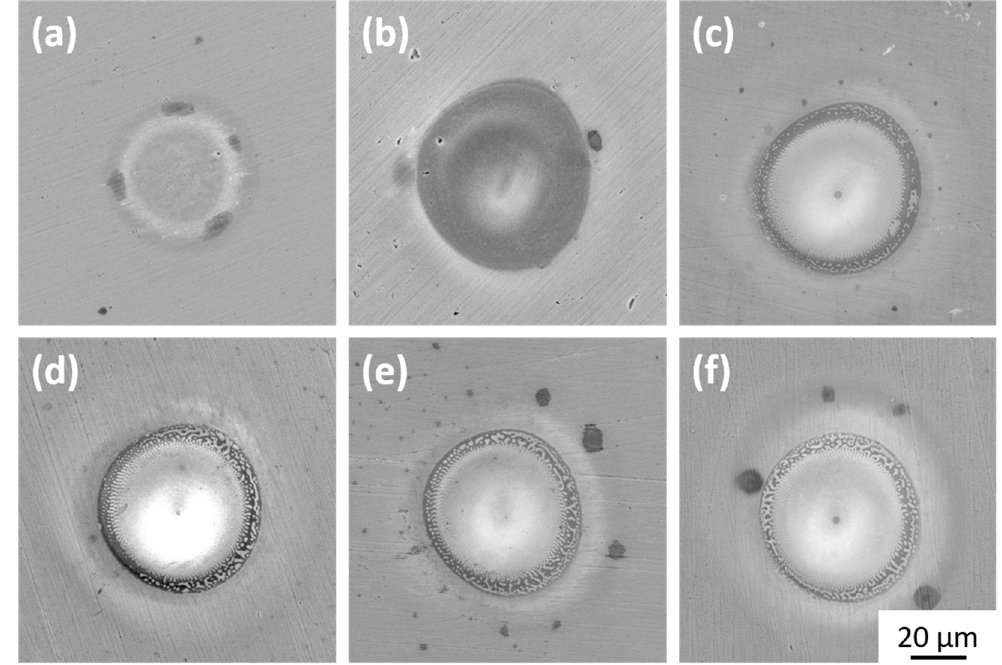
Figure 17. Patterns generated by low laser intensity on: ( a ) pure nickel, ( b ) Inconel 718, ( c ) MAR M200 + Hf + AgT, ( d ) MC2 + AgT, ( e ) AM1 + AgT and ( f ) CMSX ‐ 4 Plus + AgT.